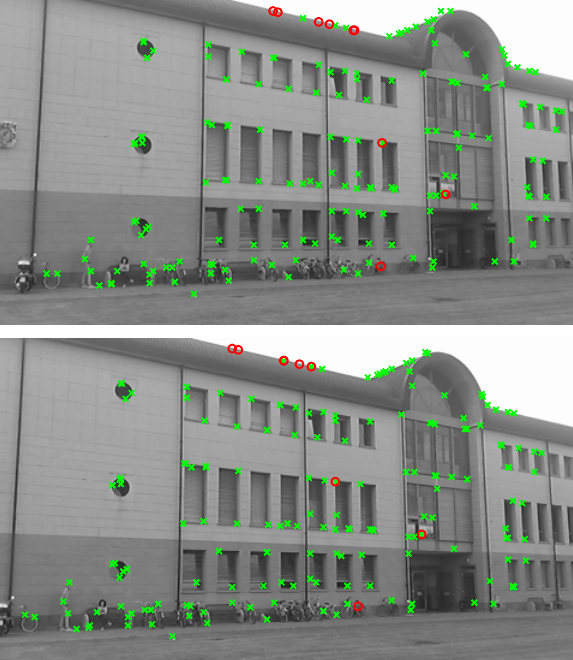
Figure 3: Feature extraction: example of features matched by means of the ASIFT method in two images. Features considered as properly matched after the execution of the RANSAC algo- rithm are shown as green circles. Mismatches are shown as red